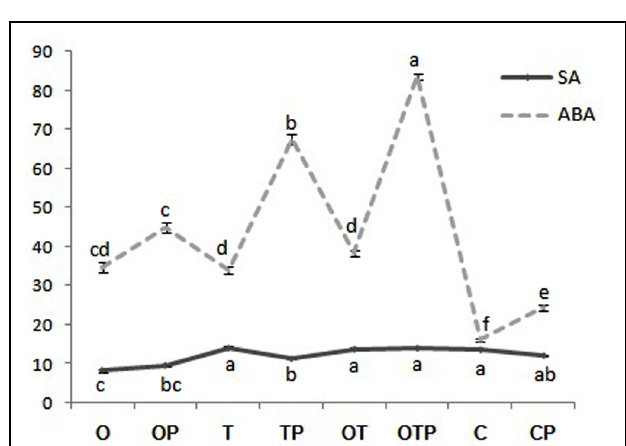
FIGURE 3 | Relative abundance of salicylic acid (SA) and abscisic acid (ABA) in pea leaves after 24 h of pathogen ( Erysiphe pisi ) challenge in different treatments: P- Pathogen E. pisi , O- P. fluorescens OKC, T- T. asperellum T42, OT- combination of OKC and T42. Error bars represent SDs from means of three measurements. Different superscript letters indicate data significantly different from the other treatments ( P ≤ 0.05; Duncan’s multiple range